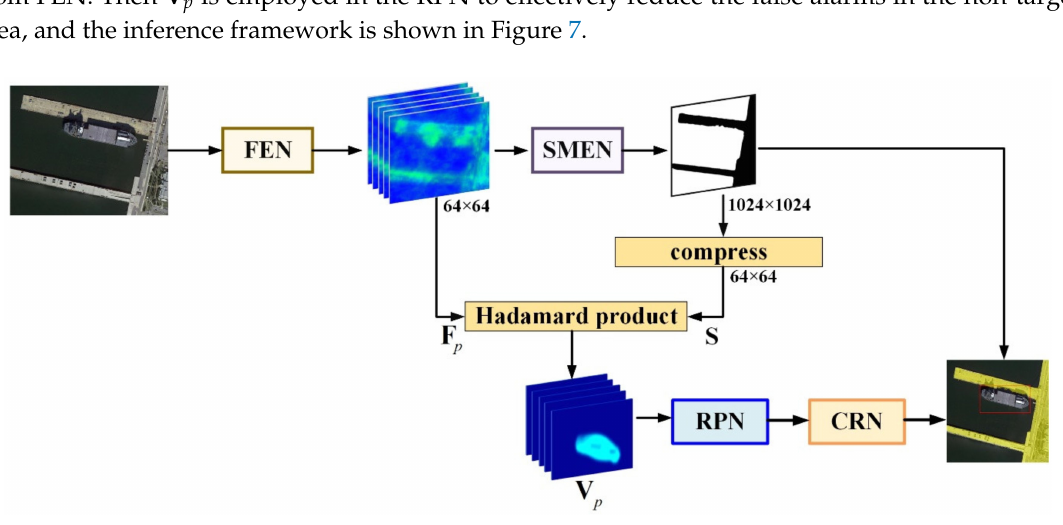
Figure 7. The inference framework of object detection based on the Mask-Faster